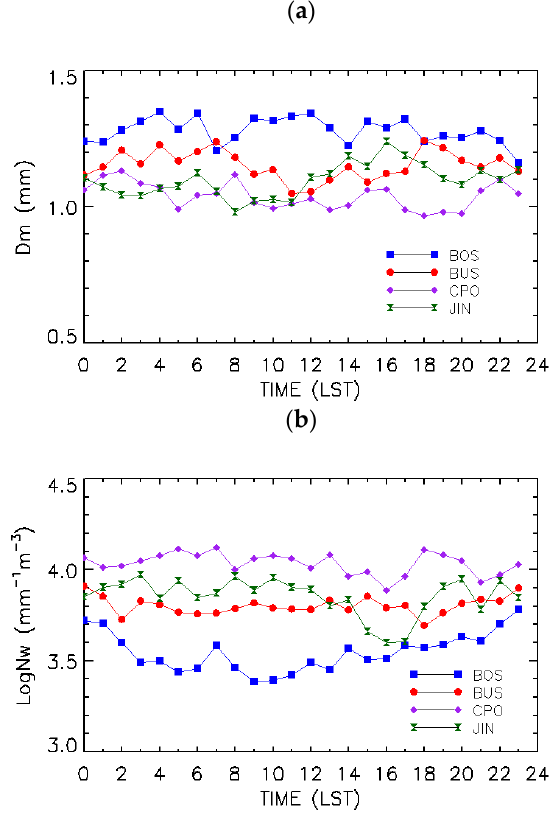
Figure 16. Time series of average ( a ) Dm and ( b ) logNw at the four studied sites. The rectangles in blue represent BOS, the triangles in red represent BUS, the circles in purple represent CPO, and the arrows in green represent the JIN site.